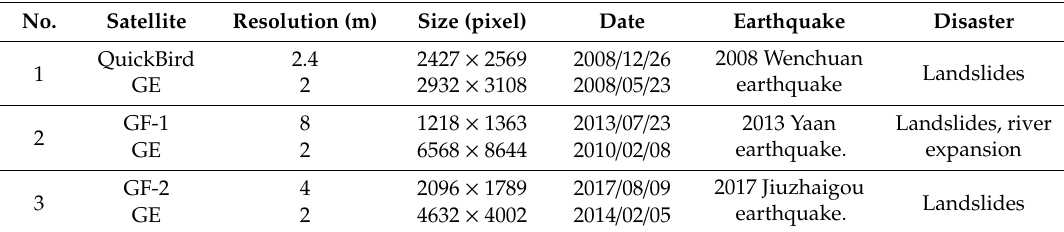
Figure 8. The Wenchuan earthquake dataset. The left ( a ) is the post-earthquake image (the input image), whereas the right ( b ) is the reference image in the pre-earthquake database. The points in red are the verification points used for calculating the accuracy of the rectified image. Table 2. Details of the three image datasets used in the